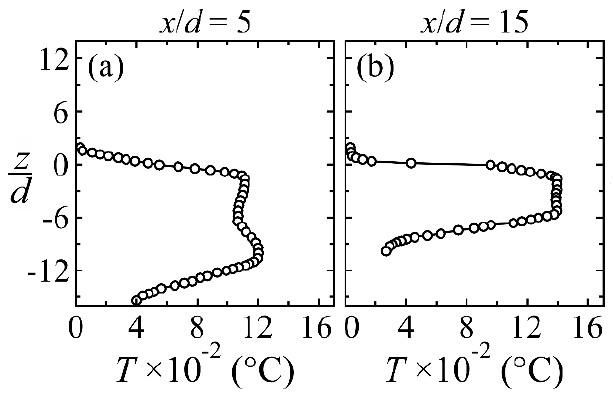
Figure 10 . Time-averaged temperature distributions at R = 0.030. θ = 15°.